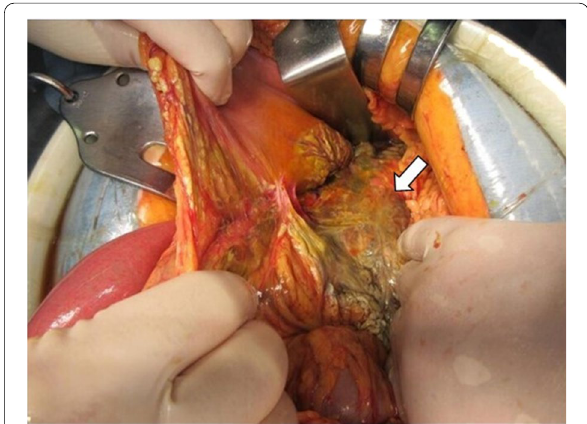
Fig. 4 Surgical view of case 2 showing extensive necrotic change of pancreas (arrow) and emphysema around the pancreatic body including the